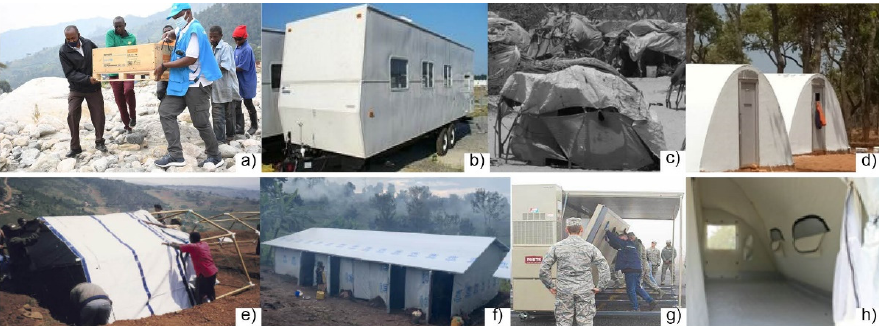
Figure 6. Selected temporary shelters. ( a ) High Performance Tent, UNICEF (© UNICEF/UN0588296/Wamala) [48]; ( b ) FEMA trailer, US agency [42,49]; ( c ) Makeshift Shelter2, refugees in Chad, 2017 [39,50]; ( d ) Lifeshelter, Jens O. Olsson [51,52]; ( e ) Bamboo tent, Shigeru Ban architect, Rwanda, 1999 (© Shigeru Ban architect) [53]; ( f ) Shelters for the Ituri crisis, ShelterCluster, Dem. Rep. Congo, 2017 and outward (©Anja Pirjevec) [39]; ( g ) Deployable truck, Forts [54]; ( h ) Self-standing family tent, ShelterCluster [55].